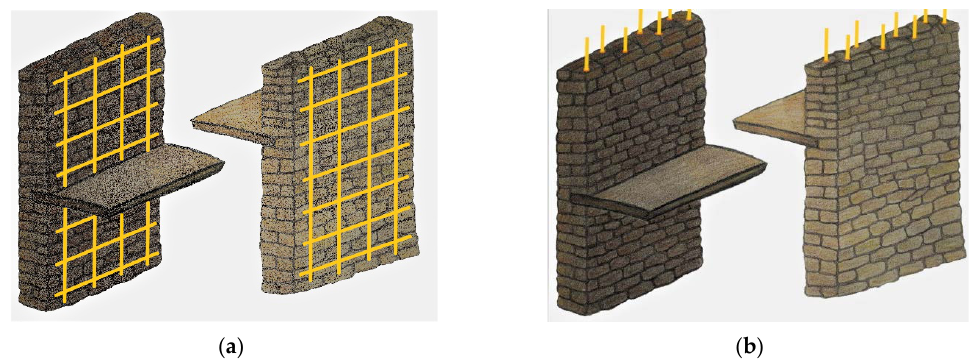
Figure 1. Schemes of the investigated retrofitting techniques: ( a ) external, ( b ) centred vertical rebars.